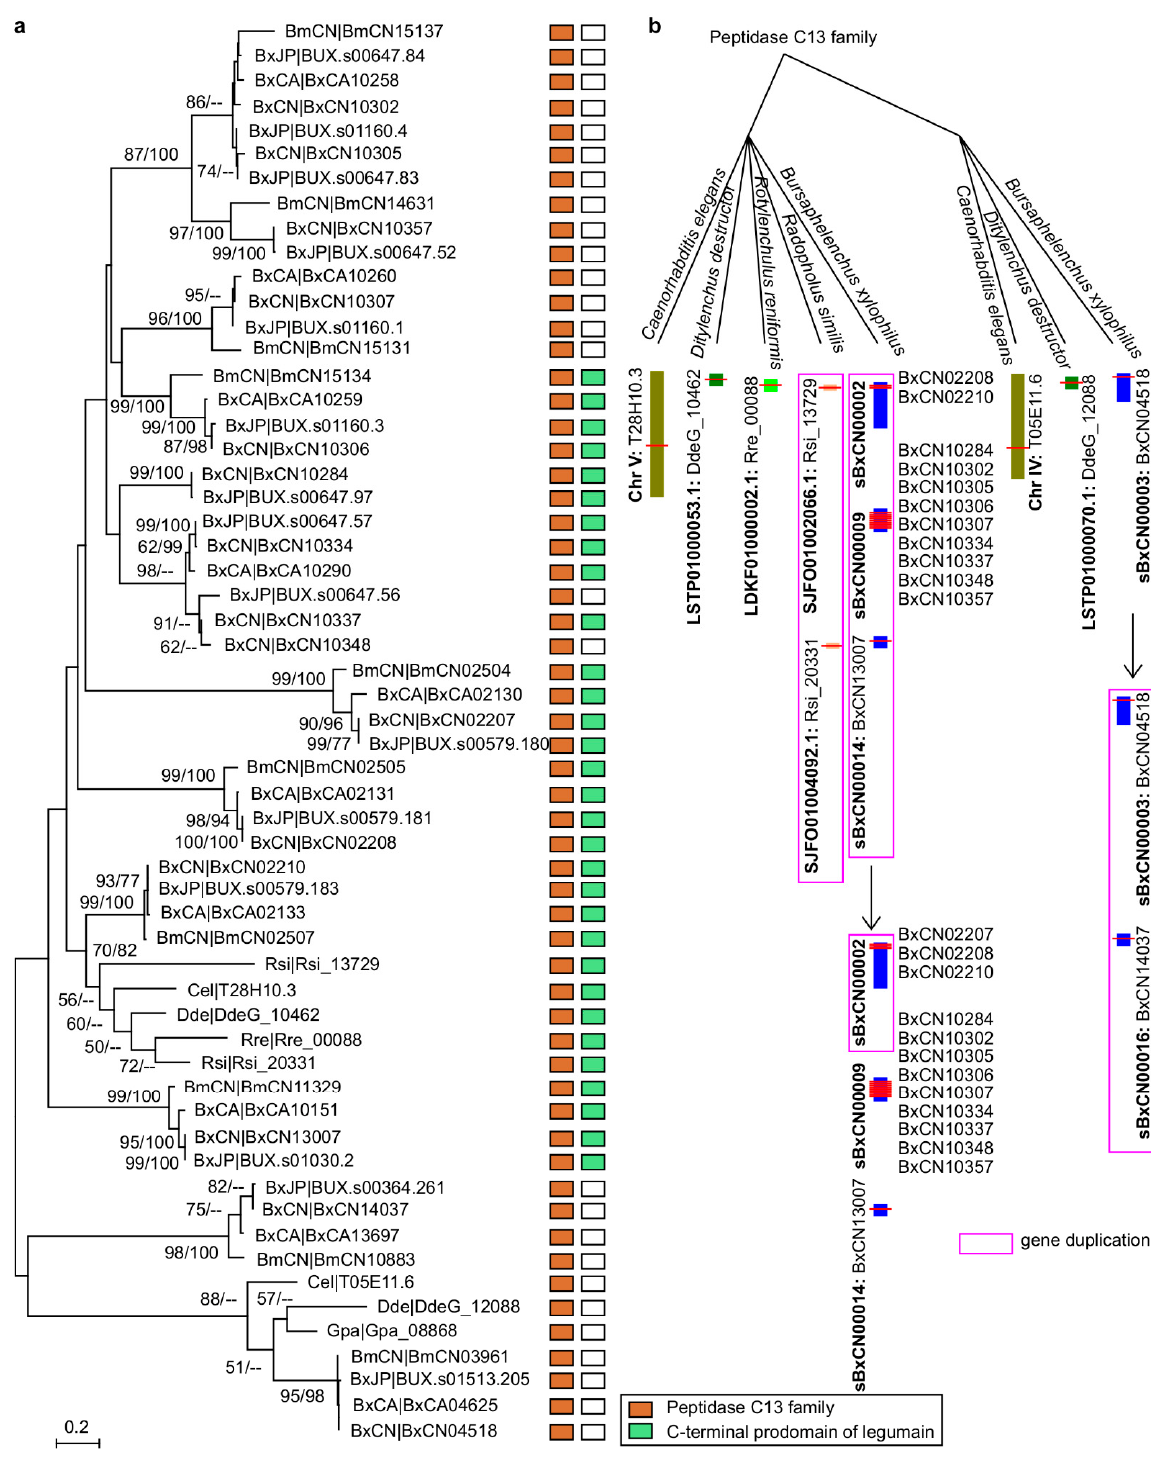
Figure 2. Phylogenetic relationship of legumains in plant-parasitic nematodes and C. elegans : ( a ) phylogeny of nematode legumains and their primary structures, i.e., a peptidase_C13 domain (PF01650); and ( a ) C-terminal prodomain of legumain (legumain_C, cd2115). The phylogenetic tree was con- structed based on full-length protein sequences. Bootstrap values of ML/NJ are showed on branches, and bootstrap value less than 50% is replaced by the marker –. The B. xylophilus -specific legumains are enclosed in the red box; ( b ) putative duplications of legumain-coding genes in the B. xylophilus genome